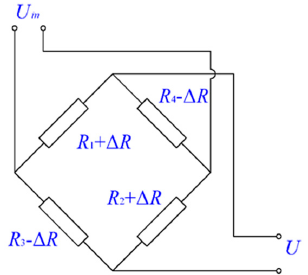
Figure 3. Schematic circuit diagram for a magneto-resistive sensor.